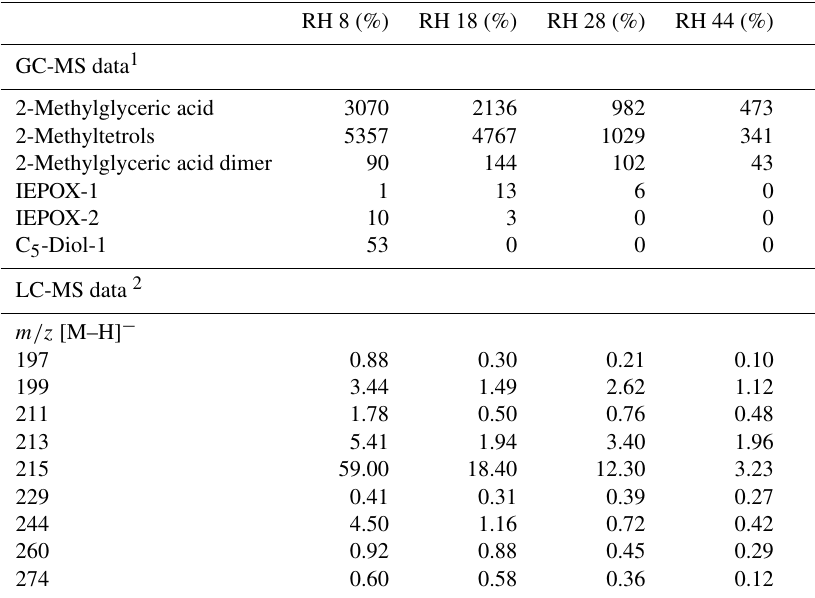
Table 4. Estimated concentrations of reaction products (ngm − 3 ) from the acidic photooxidation experiments (acidic seed [H + ] = 275nmolm − 3 air; Lewandowski et al.,